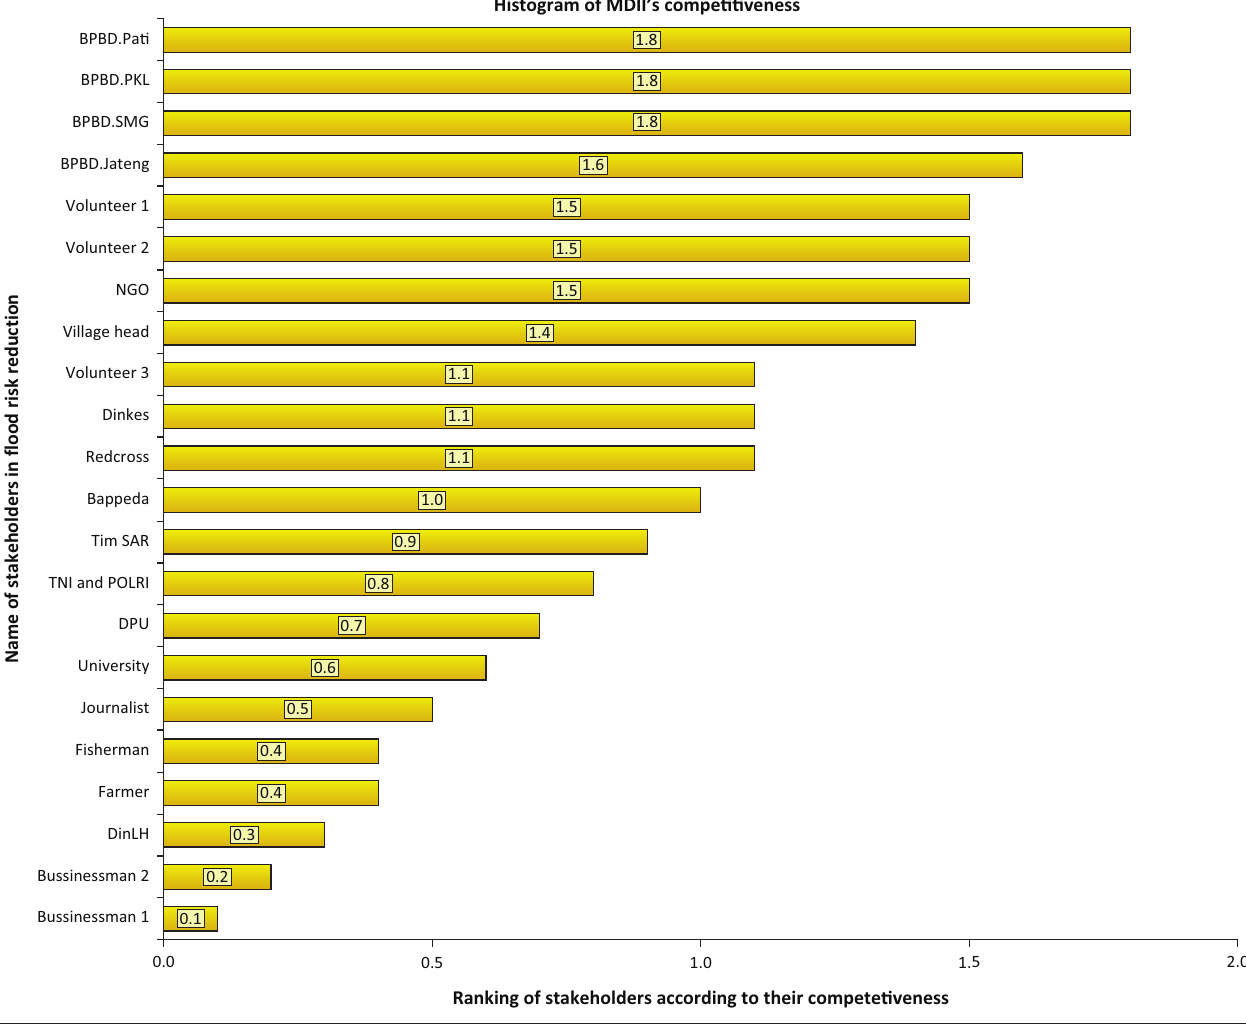
FIGURE 5: Diagram of competitiveness of stakeholders in flood risk